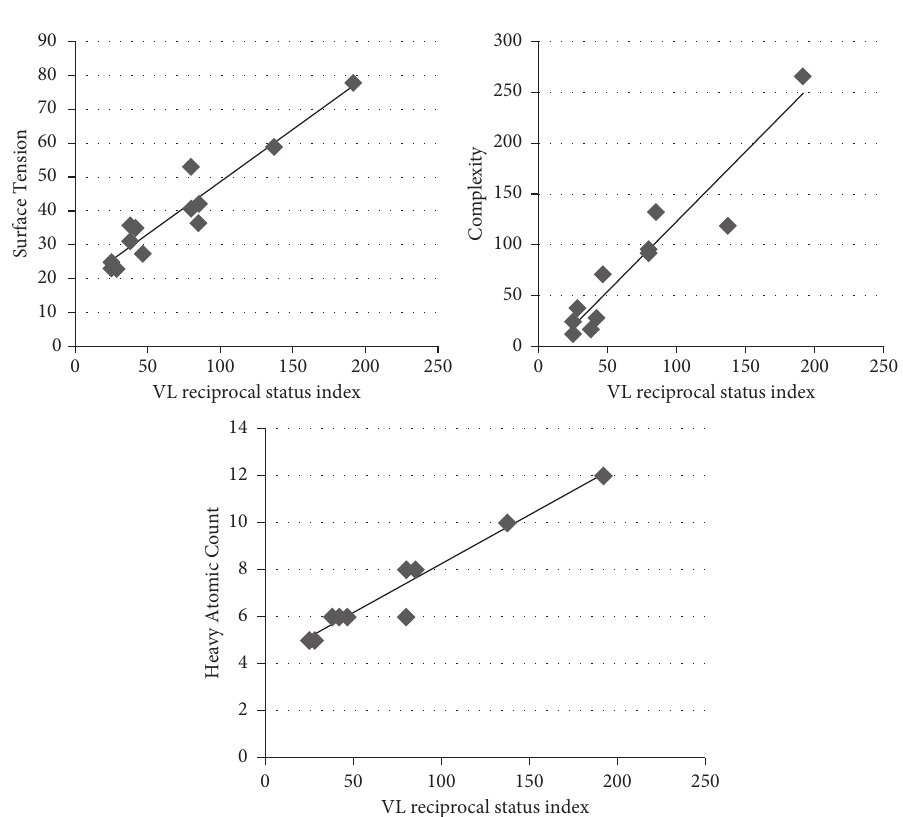
Figure 2: Correlation of VL reciprocal status index with physical properties of Butane